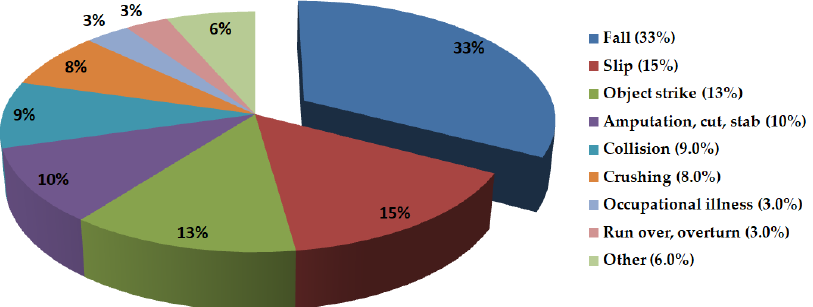
Figure 1. Distribution of industrial accidents in the construction industry in Korea by cause of accident.